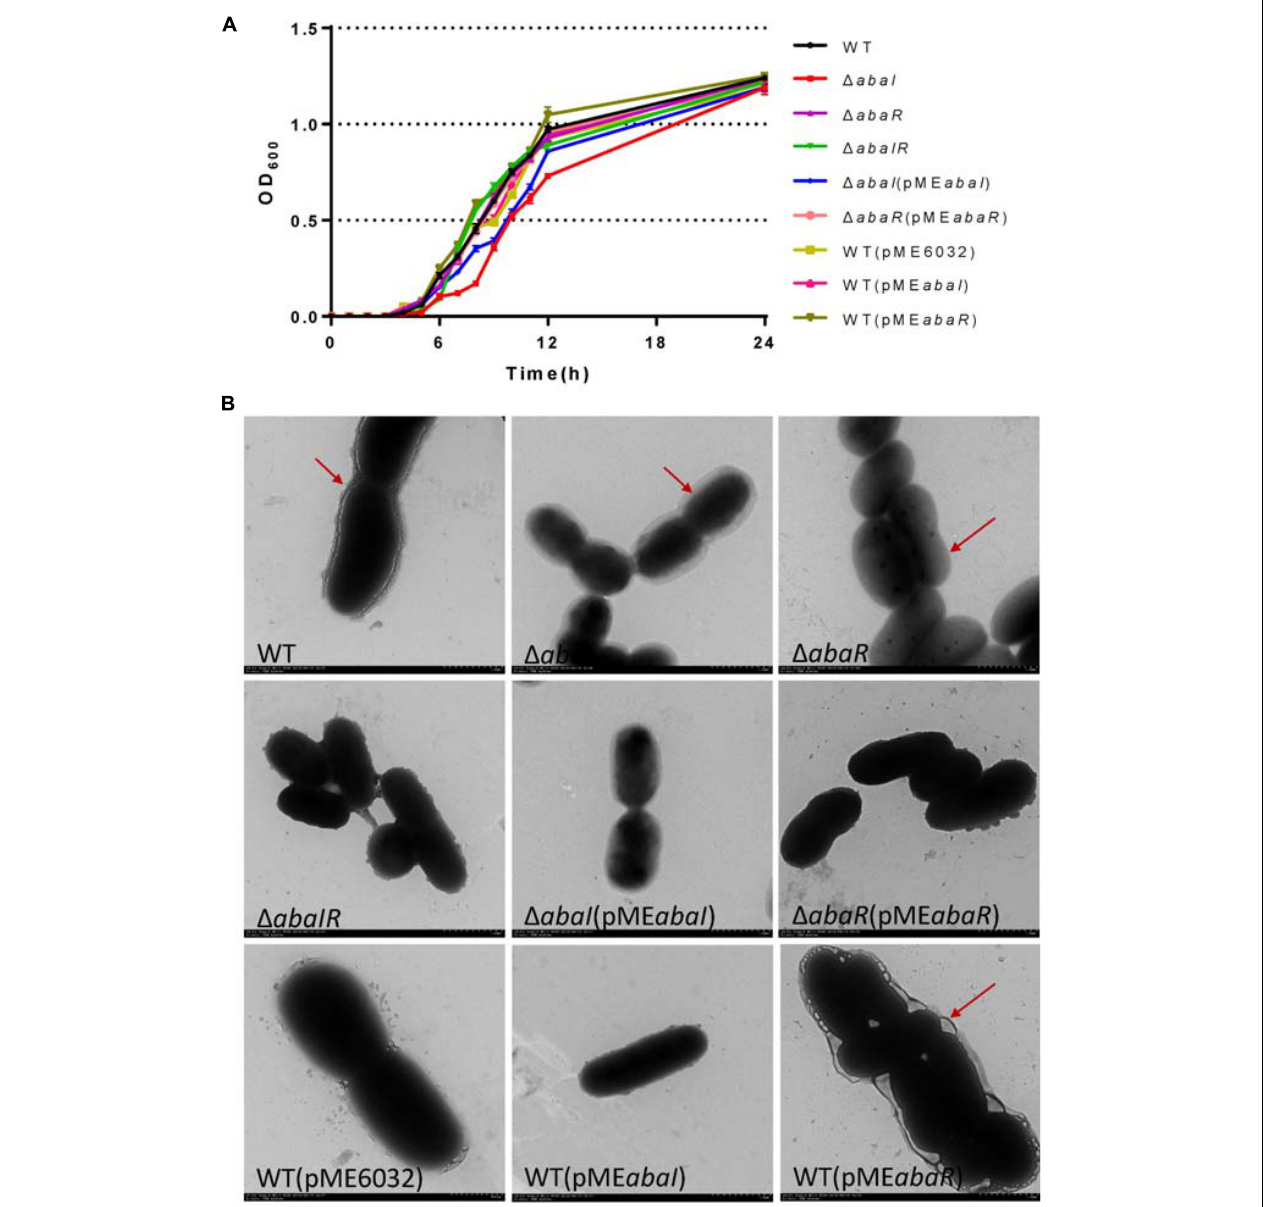
FIGURE 1 | (A) Growth curve analysis of A. baumannii and mutants in broth. (B) TEM images of the targeted bacteria. Cells were observed with a HITACHI H-7650 TEM operated at 120 kV. Scale bar = 500